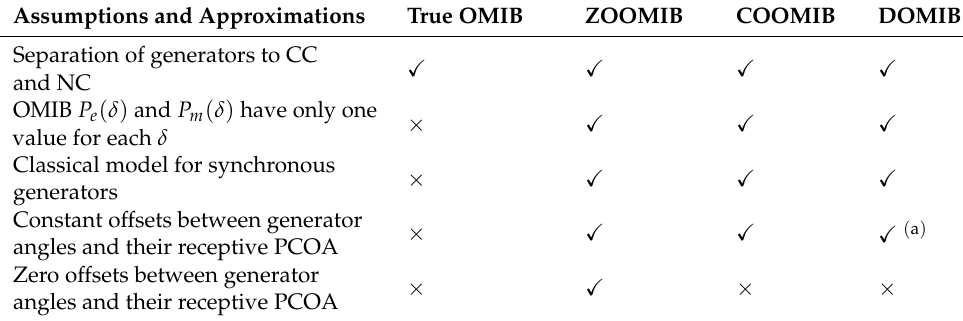
Table 1. A comparison between the assumptions of different OMIB